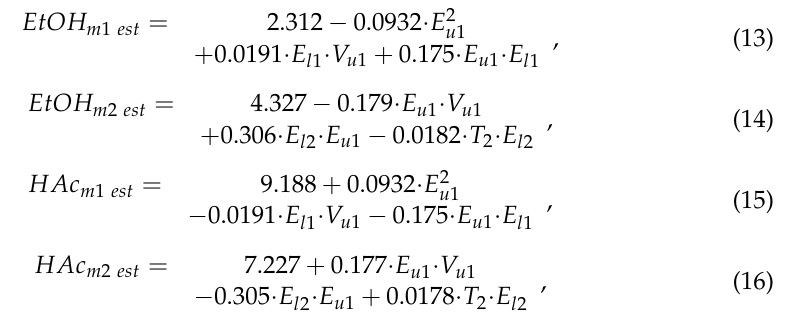
Table 6. Values of the state variables under the operating conditions maximizing and minimizing ( r A ) global est .